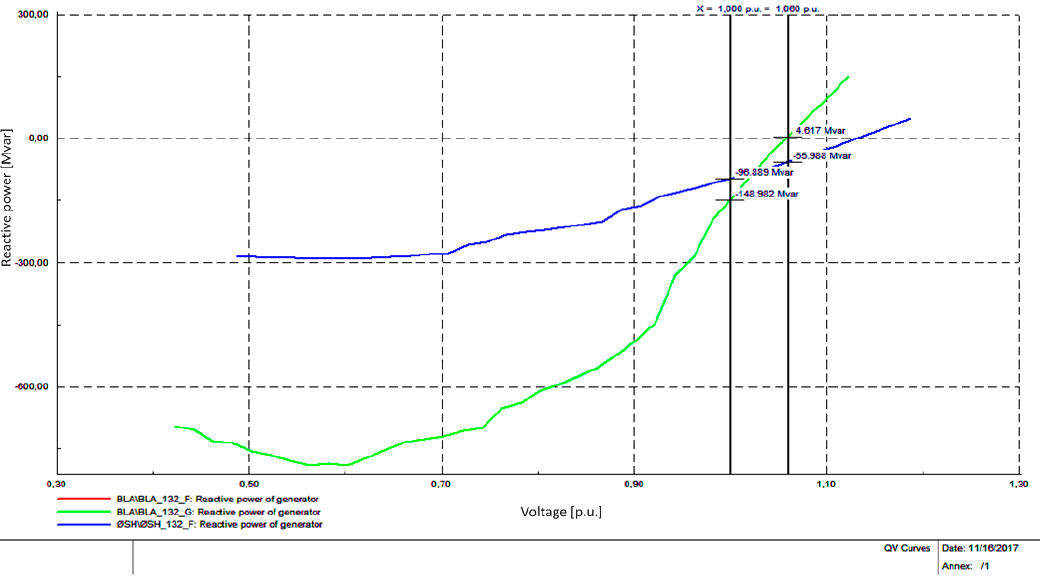
Figure 11. The QV-curves of two substations, BLA and ØSH, in a N-2 situation, with the addition of a 100 Mvar capacitor Figure 11. The QV ‐ curves of two substations, BLA and ØSH, in a N ‐ 2 situation, with the addition of a 100 Mvar capacitor bank.